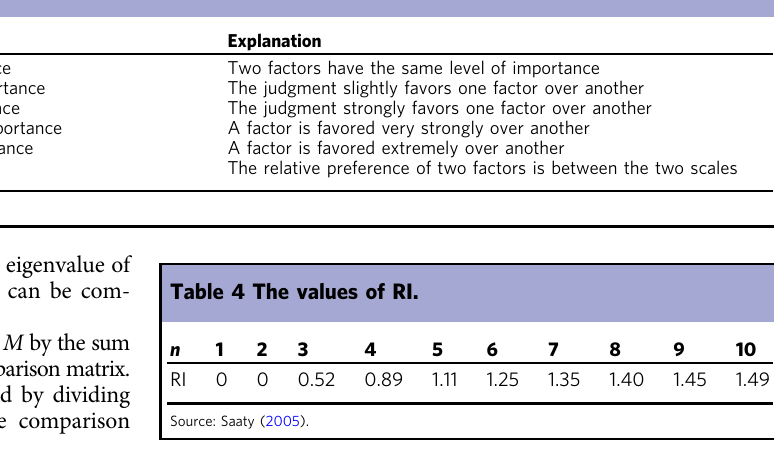
Table 3 Saaty ’ s scale for ANP